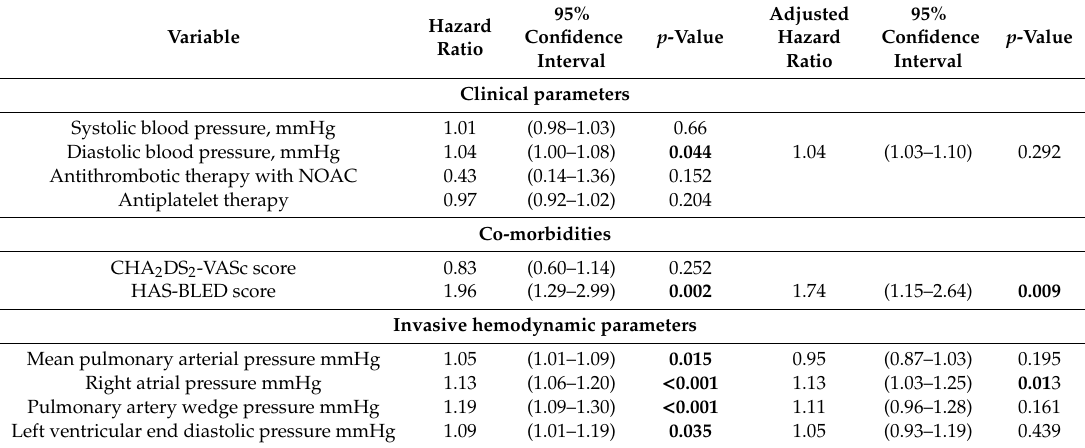
Table 4. Cox proportional hazard model of patients treated with oral anticoagulation ( n = 212) with regard to gastrointestinal bleeding events ( n = 18).